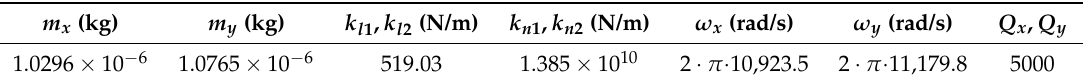
Table 3. The parameters of the shock model.